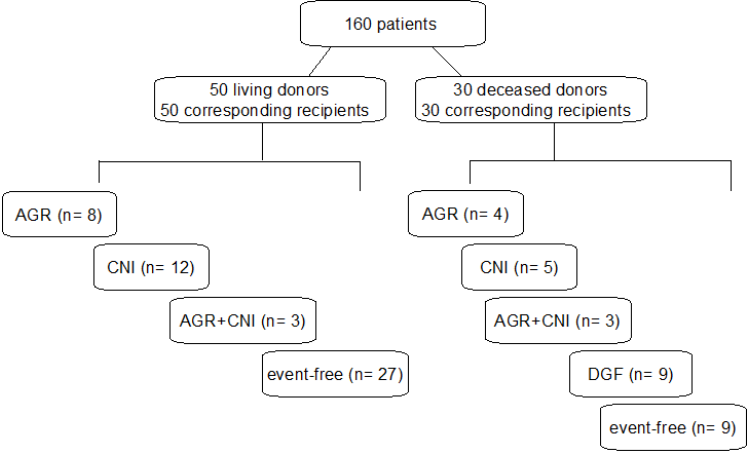
Figure 1. Patients, groups, and subgroups.